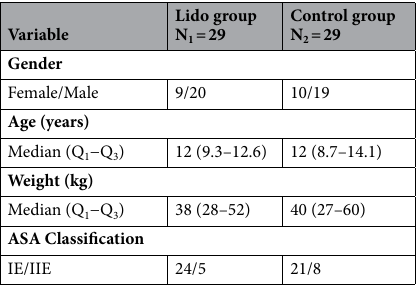
Table 1. Patients’ characteristics. Q , Q 3 —first and third quartile, Q 3 –Q 1 = IQR (interquartile range), ASA— American Society of Anesthesiologists. The Lido vs. Control group data did not differ statistically (P > 0.05)— the results of Chi 2 , and Mann–Whitney